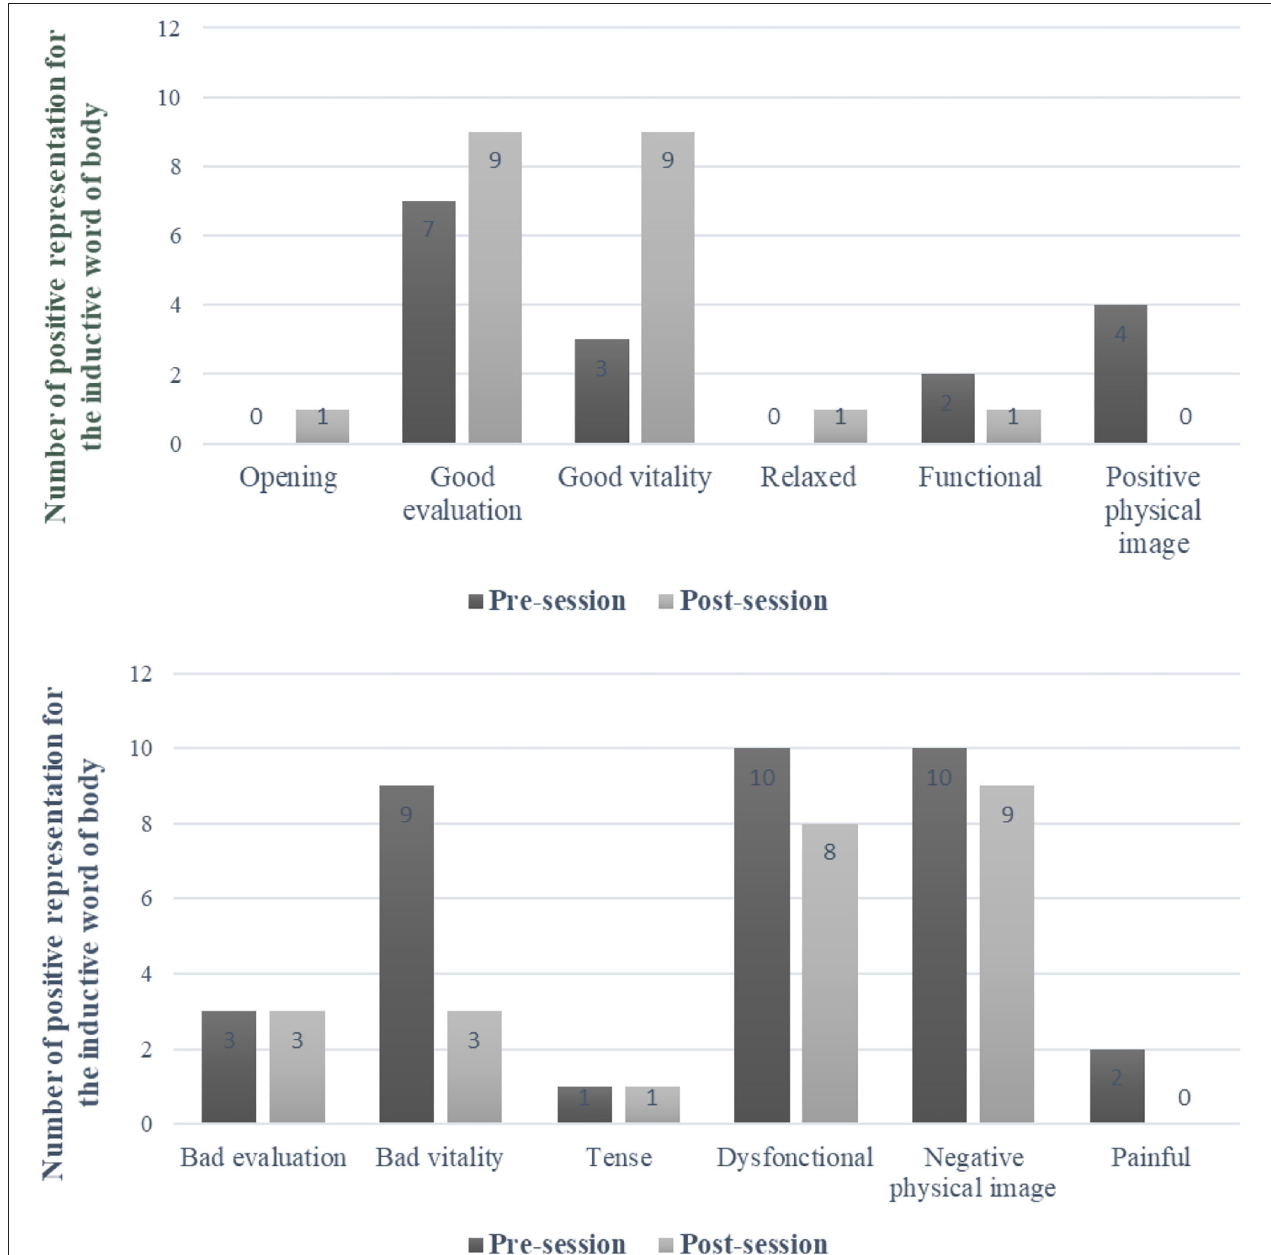
FIGURE 4 | Categories and numbers of positive (top) and negative (bottom) words used to refer to the body at pre-session and post-session.